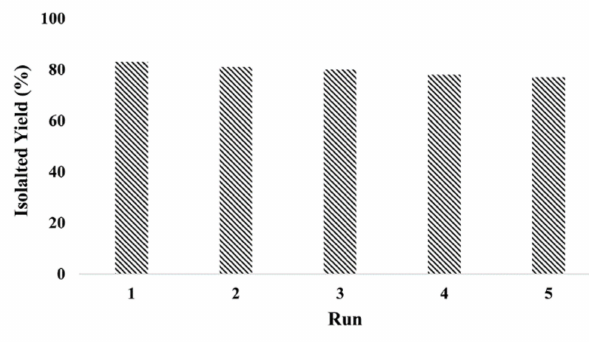
Figure 2. The reusability results of Cu@MChit